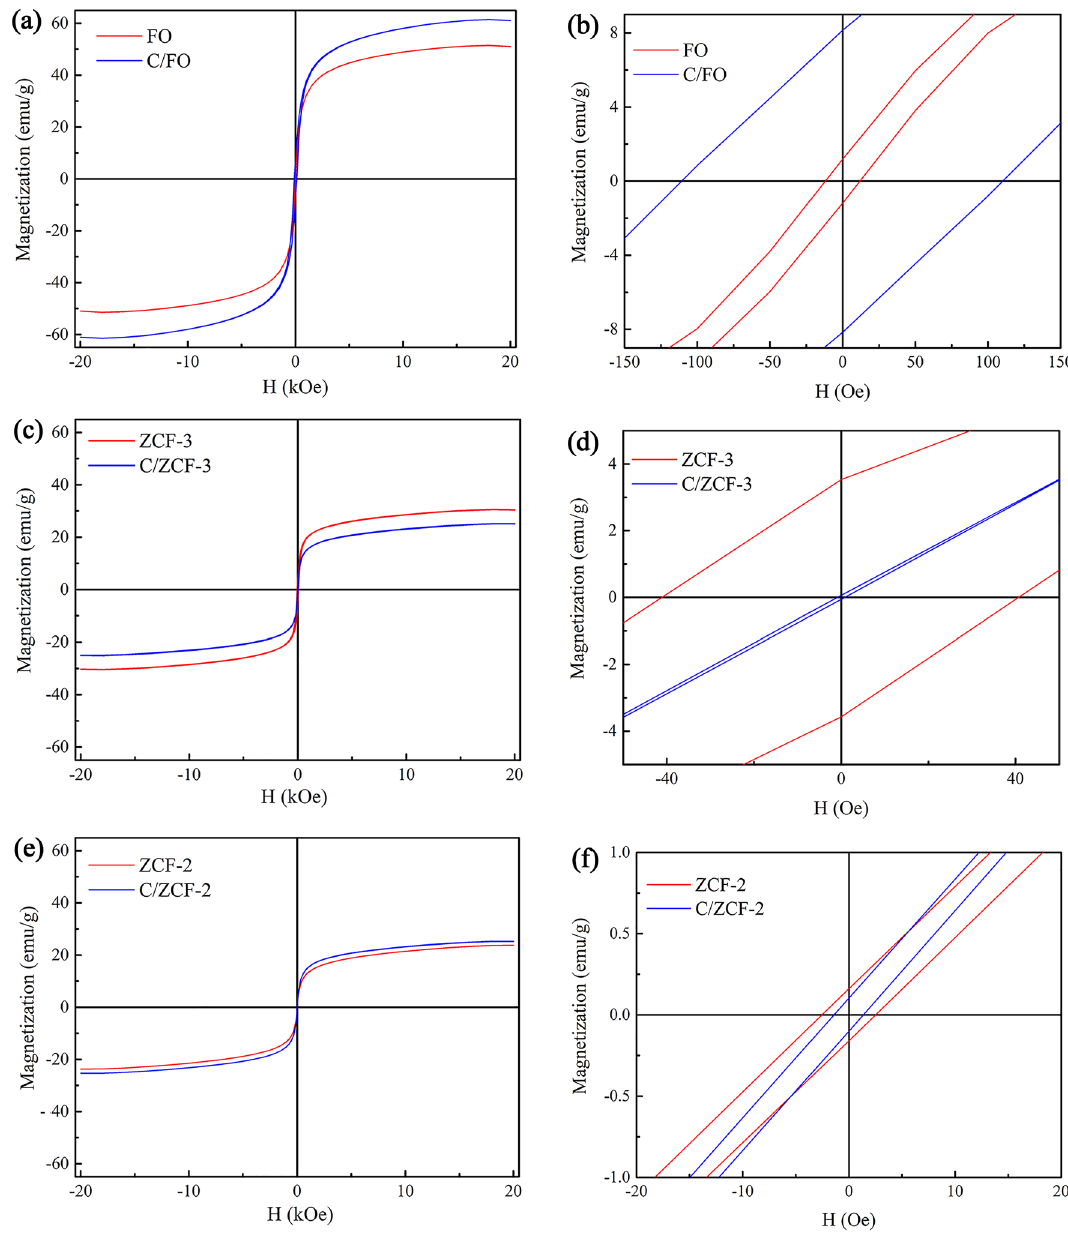
Figure 3. The magnetization curves ( a , c , e ) and their partial enlarged detail ( b , d , f ) of the samples: ( a , b ) FO and C/FO, ( c , d ) ZCF-3 and C/ZCF-3, ( e , f ) ZCF-2 and